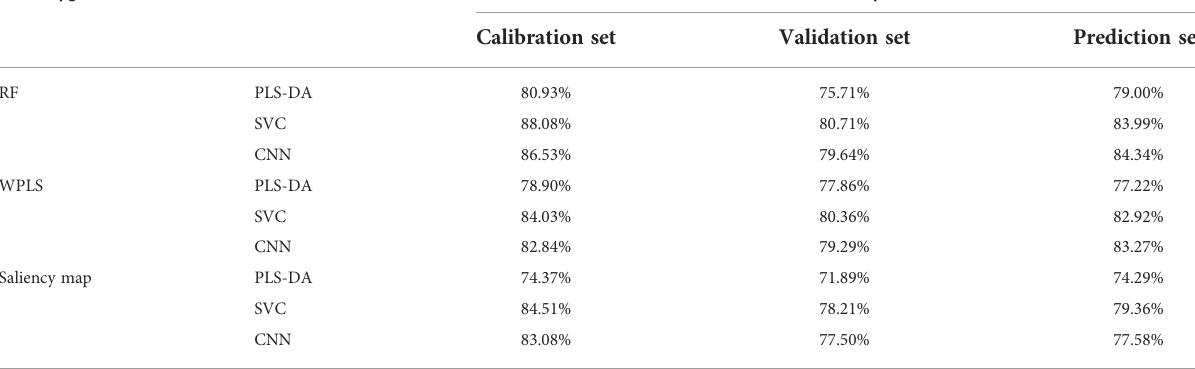
TABLE 5 The results of the classi fi cation models based on optimal wavelengths.